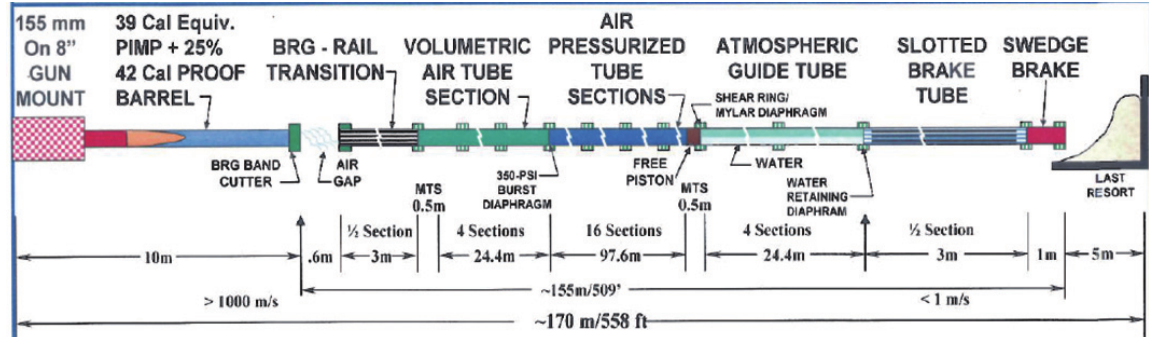
Fig. 1. Soft Catch Gun system, Picatinny